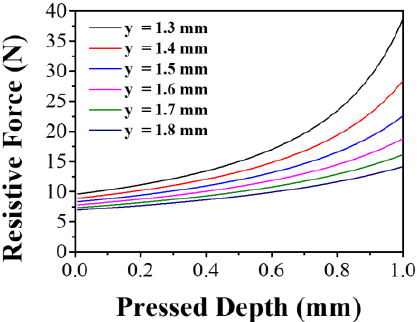
Figure 5. Simulation result of the resistive force of the haptic stylus by varying the distance between the magnetic shelter and the plunger.